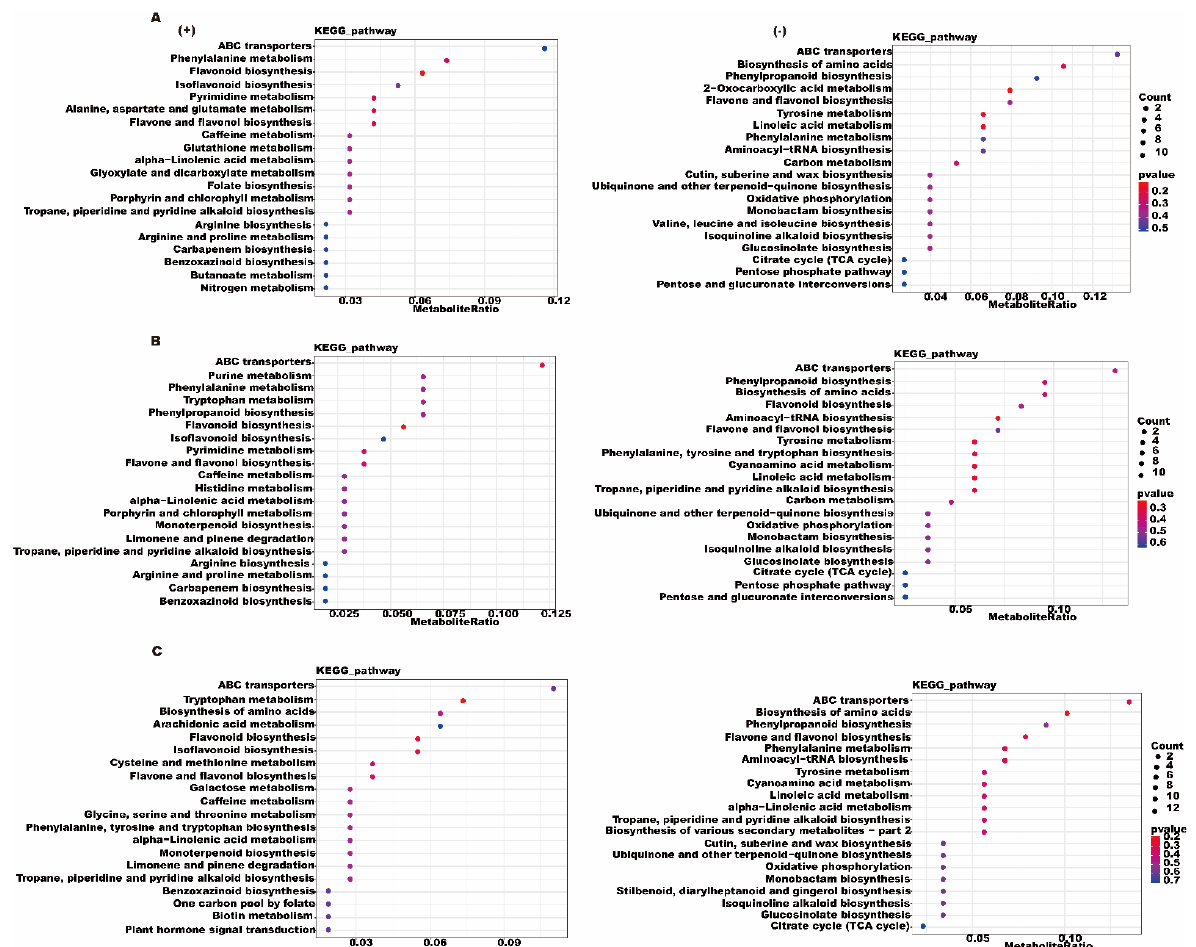
Figure 5. Metabolome analysis of Chinese fi r seeds during germination. ( A ) DAMs of seeds. ( B ) A Venn diagram in positive ion mode and negative ion mode. ( C ) PCA of samples in positive ion mode. ( D ) PCA of samples in negative ion mode. ( E ) A heatmap of DAMs in positive ion mode. ( F ) A heatmap of DAMs in negative ion mode.